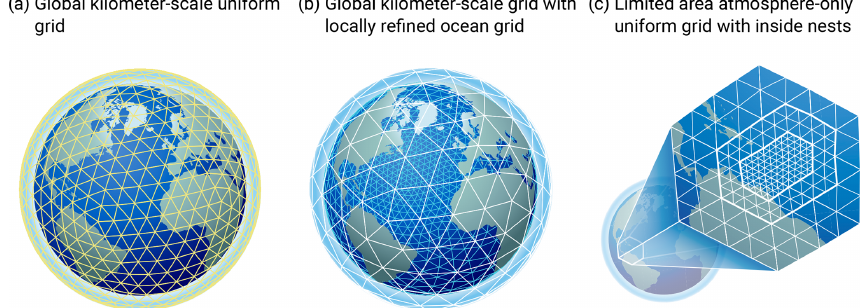
Figure 2. Grid configurations supported by ICON-Sapphire: (a) global coupled kilometer-scale simulations with a uniform grid in the atmosphere and ocean, (b) global coupled kilometer-scale simulations with a uniform grid in the atmosphere and refined ocean grid over a specific region (telescope), with white for the atmosphere grid and blue for the ocean grid, and (c) atmosphere-only large eddy simulations over limited domains with the possibility of using inside nests to consecutively refine the